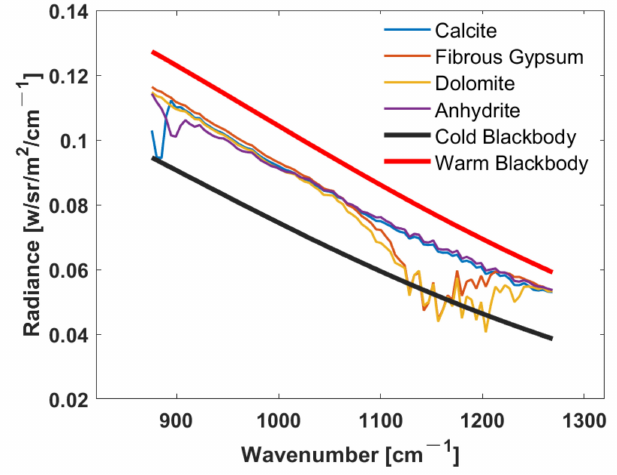
Figure 7. The radiance spectra of both the samples and the two calibration